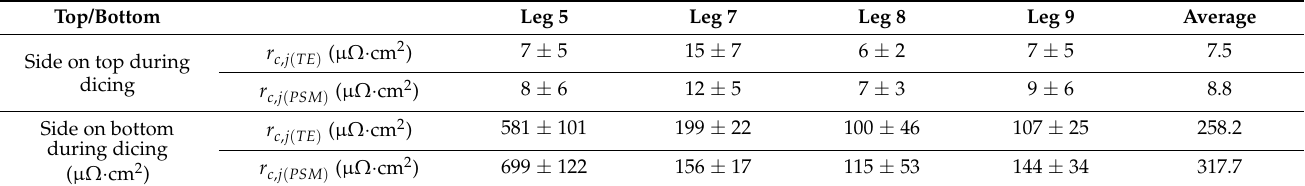
Table 2. Specific electrical contact resistances r c on both sides of a pellet contacted with Al foils, after dicing into several legs. legs 1, 2 and 3 broke during grinding. Legs 4 and 6 got detached from the sample holder and are therefore not identifiable.